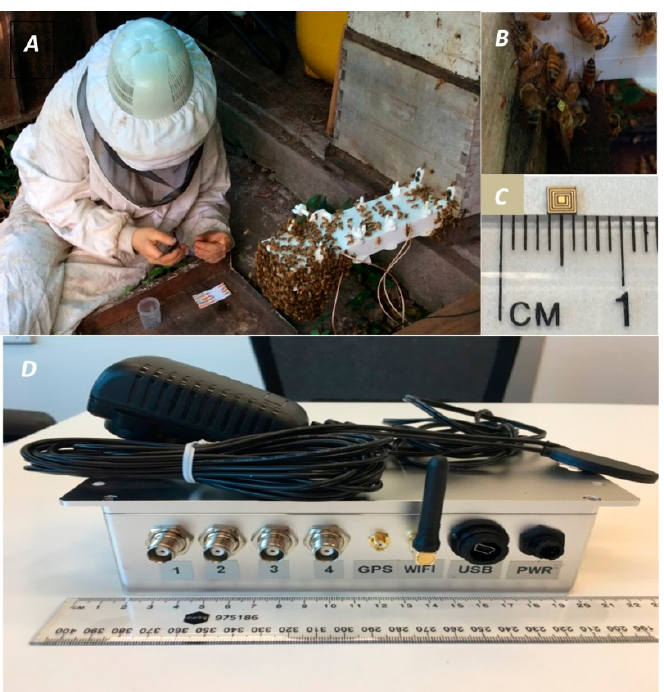
Figure 2. ( A ) Drones being tagged beside the hive. The white box at the entry is where the two pairs of patch-type RFID antennas are located. ( B ) Drone fitted with RFID microchip. ( C ) RFID microchip (Tag). ( D ) Reader unit with four connectors visible (one for each RFID antennas, Wi-Fi antenna, GPS connector and data and power connectors. A full description of this system is provided at